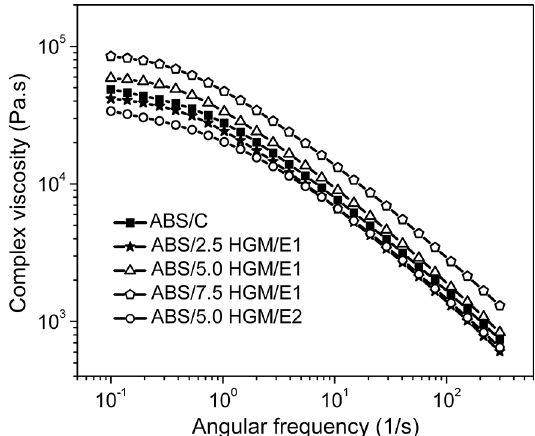
Figure 4. Complex viscosity (η * ) versus angular frequency for composites with 2.5, 5.0 and 7.5 wt.% of HGM and composite with high impact